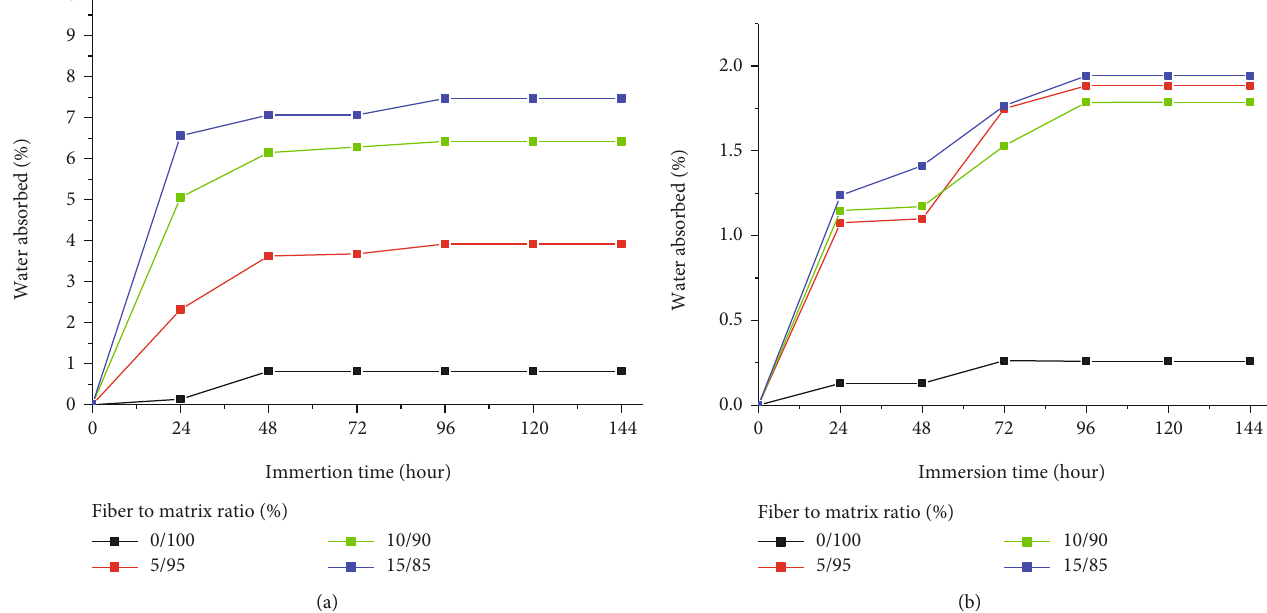
Figure 15: Water absorption percentage (%) of (a) unmodi fi ed composites and (b) modi fi ed composite at di ff erent time intervals.